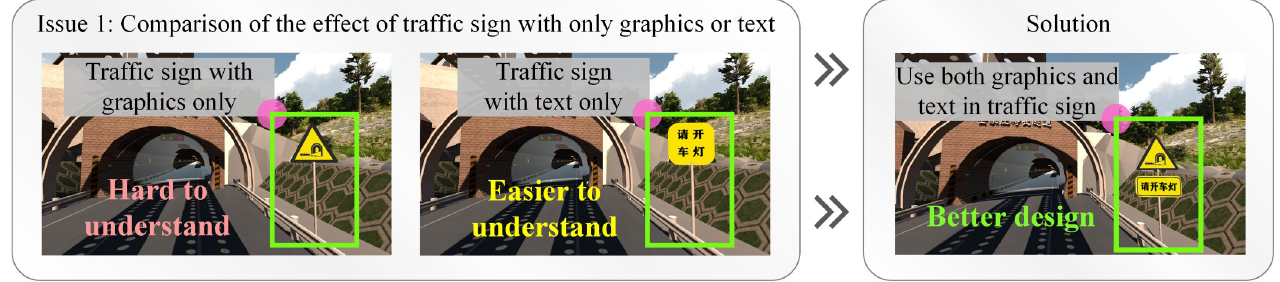
Fig 12. The design optimization of signs for driving lights.